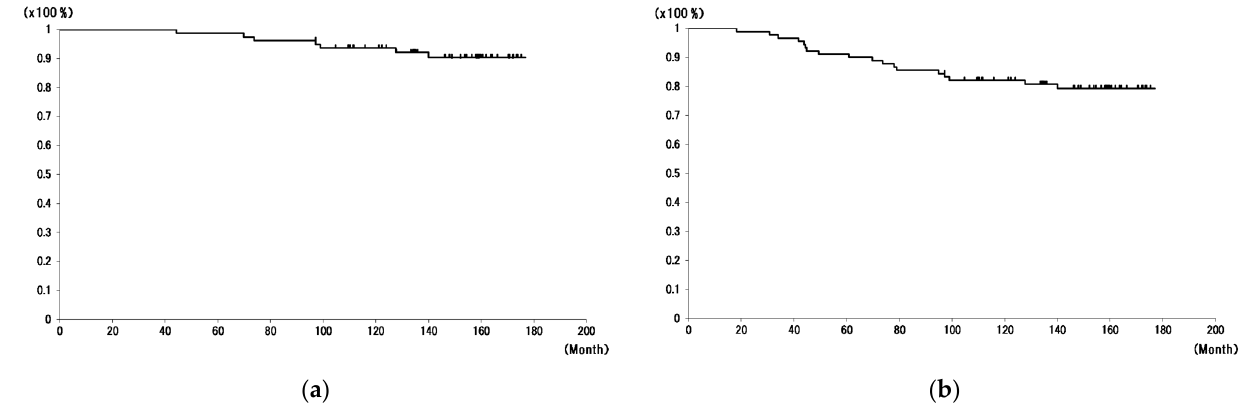
Figure 2. Implant and follow-up survival. The survivorship of revision endpoint ( a ) and the survivorship of revision and loss of follow-up (including transfer to another hospital and no visit) ( b ). We assessed radiological outcomes in 64 patients (69 hips), excluding one hip that was infected 3.5 years after primary arthroplasty. The mean acetabular cup inclination was 46.8° (±SD, 6.9°), the mean anteversion was 19.3° (± 6.0°), and the mean RFO on the operated hip to the contralateral hip was 0.914 (± 0.256). The stress shielding progressed to grade 3 or 4 in 27 hips (39.1%) during the study period. Forty-eight hips had no PTs and 14 had PTs but no revision surgery. Seven patients (7 hips) underwent revision surgery for ARMD. In the radiological analysis, the mean cup angle of inclination was the highest in the patients with revision surgery for ARMD (57.8°) compared with the patients with PTs but no revision surgery (47.7°) and those with no PTs (46.3°). The mean RFO was significantly higher in the patients with revision surgery for ARMD (1.043) than that of the patients with PTs but no revision surgery (0.787) (Table 2). The mean RFO in the patients with no PTs (0.932) was not significant compared with the patients with revision surgery for ARMD and those with PTs but no revision surgery. Table 2. Evaluation among hips without pseudotumors, with pseudotumors but no revision sur- gery, and with revision surgery for adverse reactions to metal debris. ARMD, adverse reactions to metal debris; PT, pseudotumor; PT − , hips without PTs; Not rev. with PT+, hips with PTs but no revision surgery; Revision for ARMD, hips with revision surgery for ARMD.